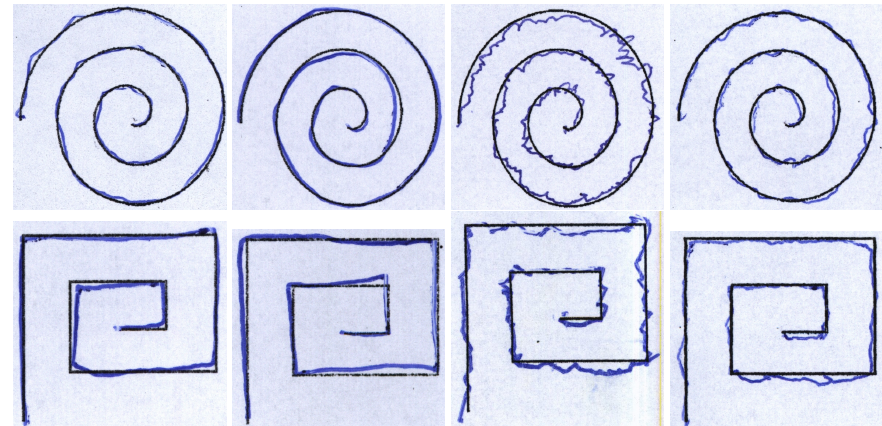
Figure 2. Examples of spirals and meanders extracted from the HandPD dataset [21]. First and second column: 58-year-old male and 28-year-old female individuals from the control group. Third and fourth column: 56-year-old male and 65-year-old female individuals from the patient